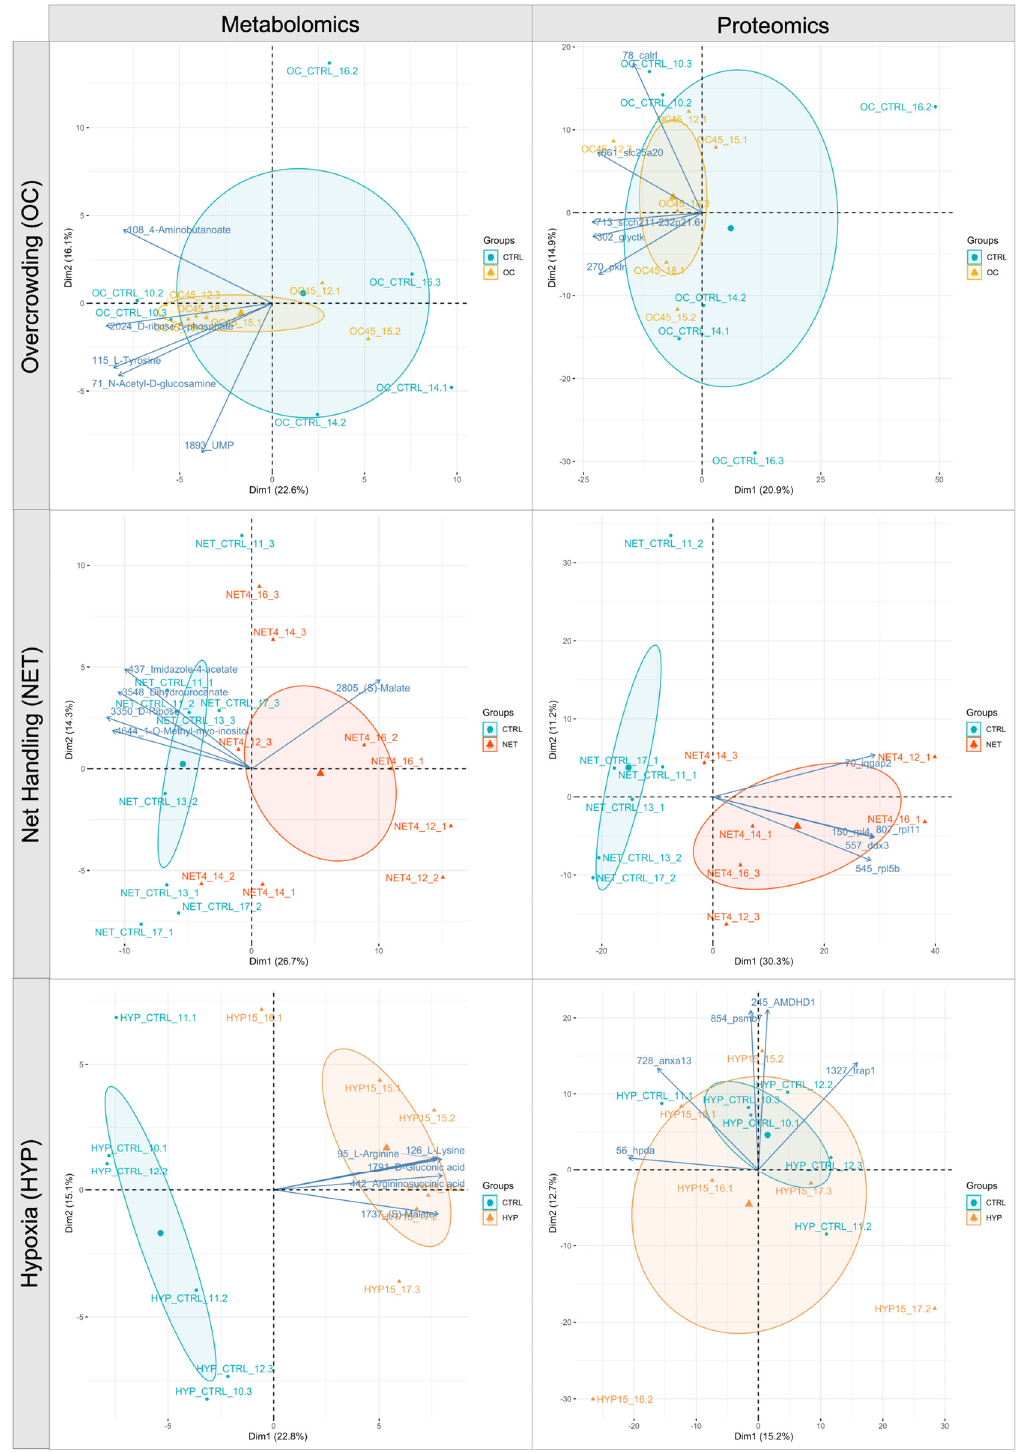
Figure 1. Principal component analysis (PCA) biplots of the liver proteomics and metabolomics data of gilthead seabream subjected to overcrowding (OC), net-handling (NET) and hypoxia (HYP) challenges. Each point represents a biological replicate’s projection, and experimental groups within trials are represented by a unique color, as indicated in each legend. The largest point represents the group mean. The axes’ percentages indicate the proportions of explained variance. The arrows depict the top-five most weighted variables.